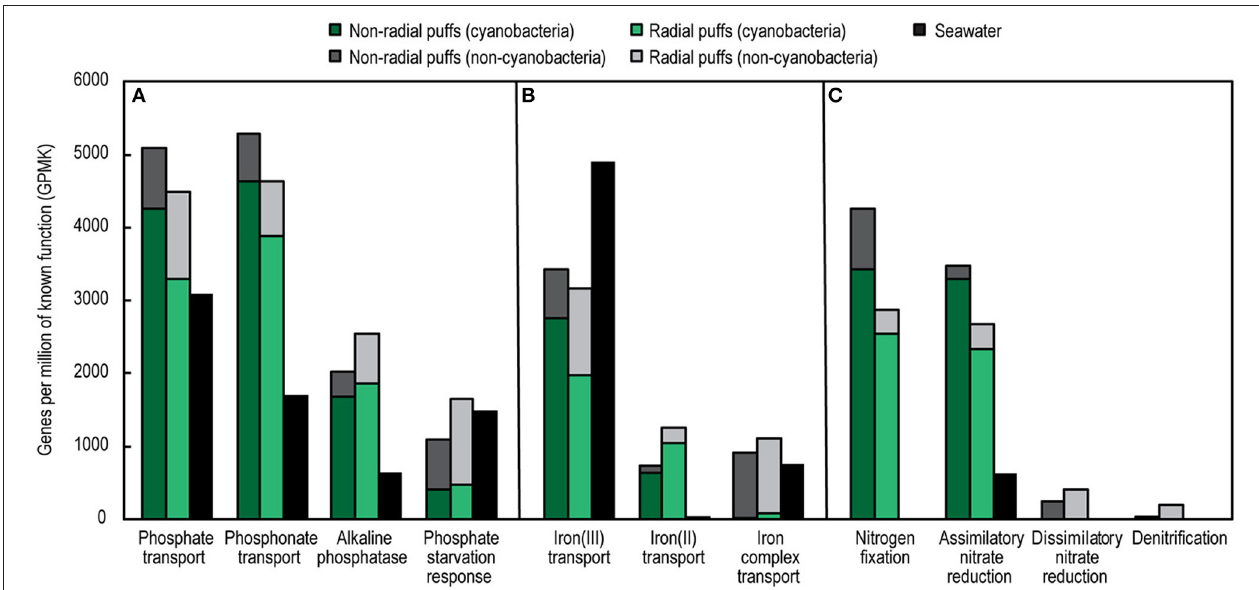
FIGURE 7 | Abundances of select genes and pathways involved in phosphorus (A) , iron (B) , and nitrogen (C) cycling from Trichodesmium colony and surface seawater metagenomes. Colors represent sample type and taxonomic assignment. See Table S6 for a list of KO included in each